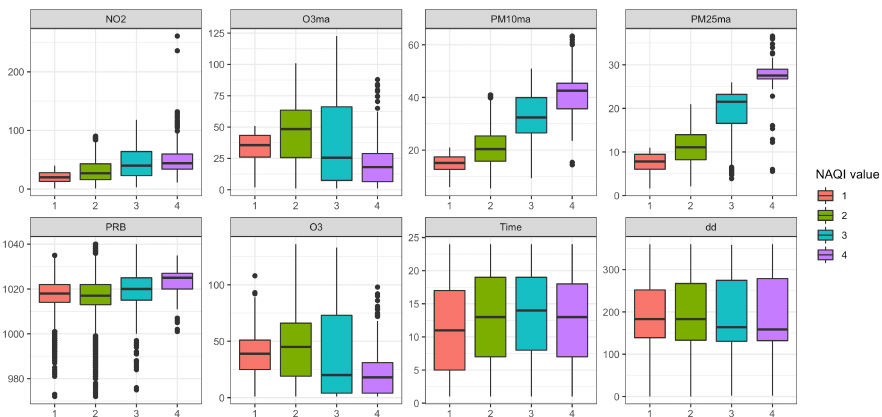
Figure 2. Box-plots of some of the predictive variables for each value of the air quality index.